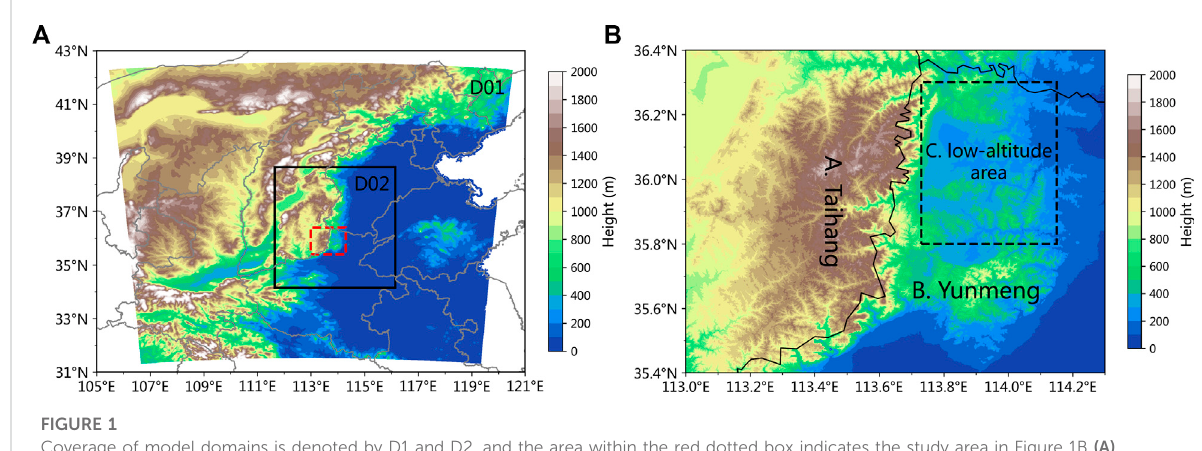
FIGURE 1 Coverage of model domains is denoted by D1 and D2, and the area within the red dotted box indicates the study area in Figure 1B (A) . Topographic features of the study area (B)